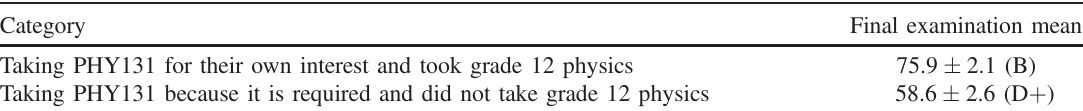
TABLE IV. Two different categories of students and their final examination grades. Category